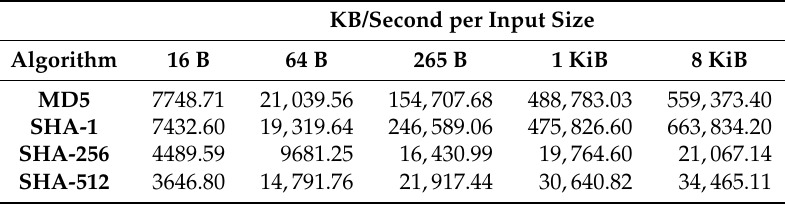
Table 2. OpenSSL self-assessment of its hash functions’